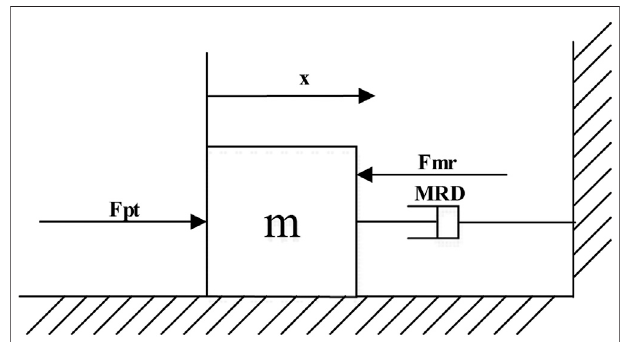
FIGURE 1 | Simpli fi ed mechanical model of magnetorheological (MR) impact buffer system.